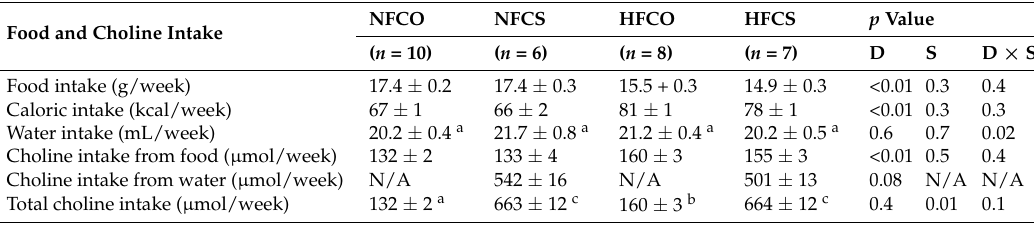
Table 1. Average weekly food and choline intake of dams 1 .